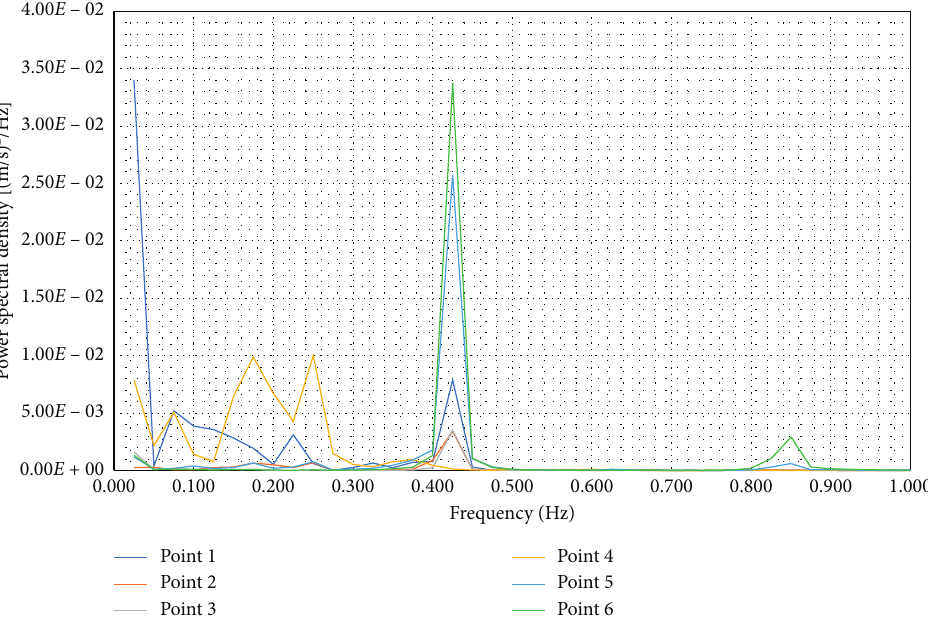
Figure 12: Power Spectral Density versus